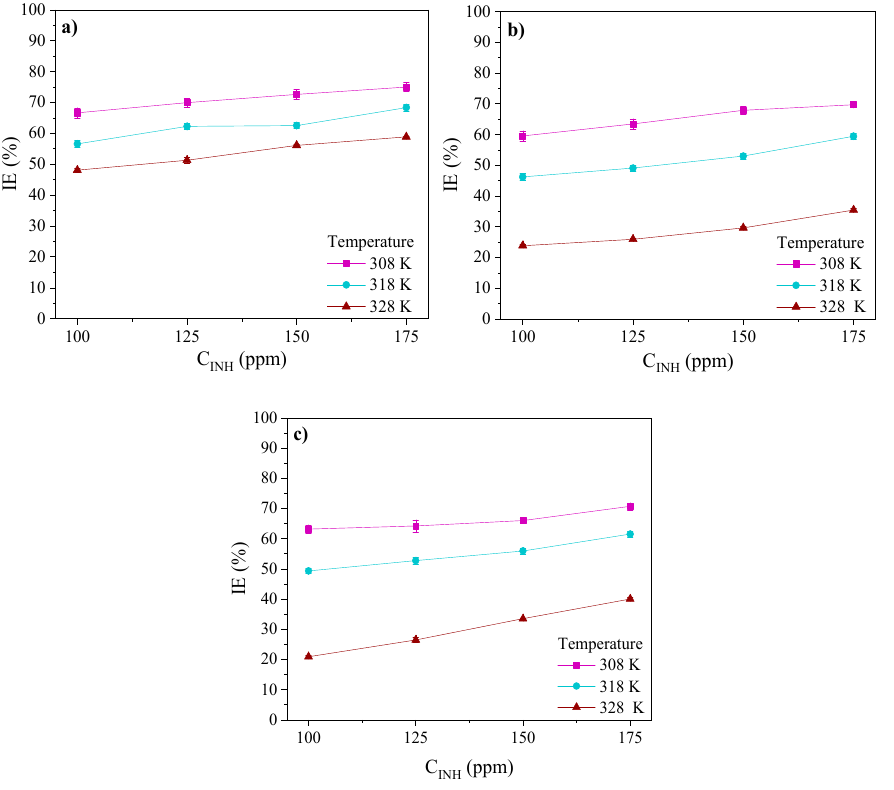
Figure 6. Inhibition efficiencies of API 5L X60 steel in 1 M H 2 SO 4 in the absence and presence of PILs: ( a ) Poly[VIMC4][Im], ( b ) Poly[VIMC2][Br] and ( c ) Poly[VIMC4][Br]. The EIS spectra of API 5L X60 steel in the absence and presence of CIs at 308, 318 and 328 K are shown in Figures 7–9, respectively. The behavior of the real ( Z (cid:48) ) and imaginary ( Z ”) impedances in the Nyquist spectra shows a capacitive depreciated loop controlled by a charge transfer process and an inductive loop at low frequencies. On the other hand, in the presence of PILs, the Bode plots exhibit the displacement of the impedance module |Z| toward higher values with respect to the blank, which is associated with the adsorption of the CIs on the metallic surface [39]. The latter suggests that the evaluated CIs retarded the kinetics of the redox reactions part of the corrosion process of steel in acid medium [40]. At intermediate frequencies, the Bode plots presented maximal phase angle values ascribed to the capacitive behavior of the electric double layer in the metal-solution interface. Although the temperature increase diminished the maximal phase angle